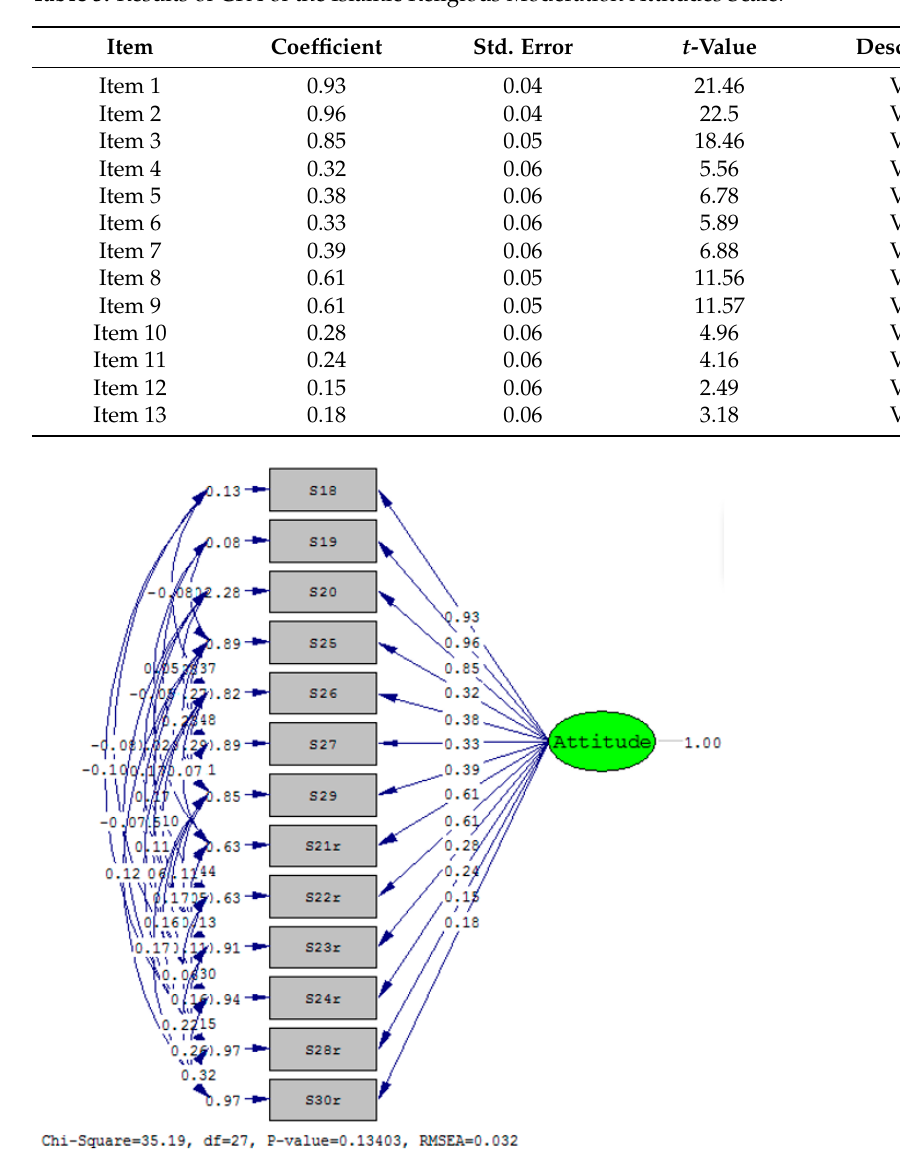
Table 4. Results of CFA of the Islamic Religious Moderation Intentions Scale.